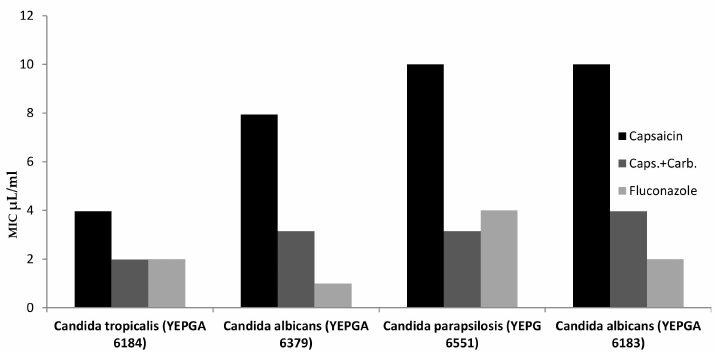
Figure 5. Fungal Minimum Inhibitory Concentration (MIC) µ L/mL of Capsaicin from Carbopol- based formulation.